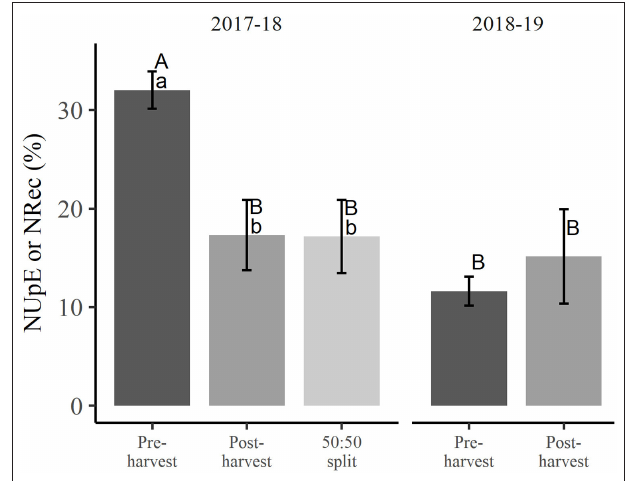
FIGURE 1 | Nitrogen uptake efficiency (NUpE) in the 2017–2018 season and nitrogen recovery efficiency (NRec) in the 2018–2019 season following different N application treatments. Different uppercase letters denote significant interaction ( p < 0.05) between treatments and seasons and different lowercase letters indicate significant differences ( p < 0.05) between treatments within a season (error bars represent ± SEM, n = 4).